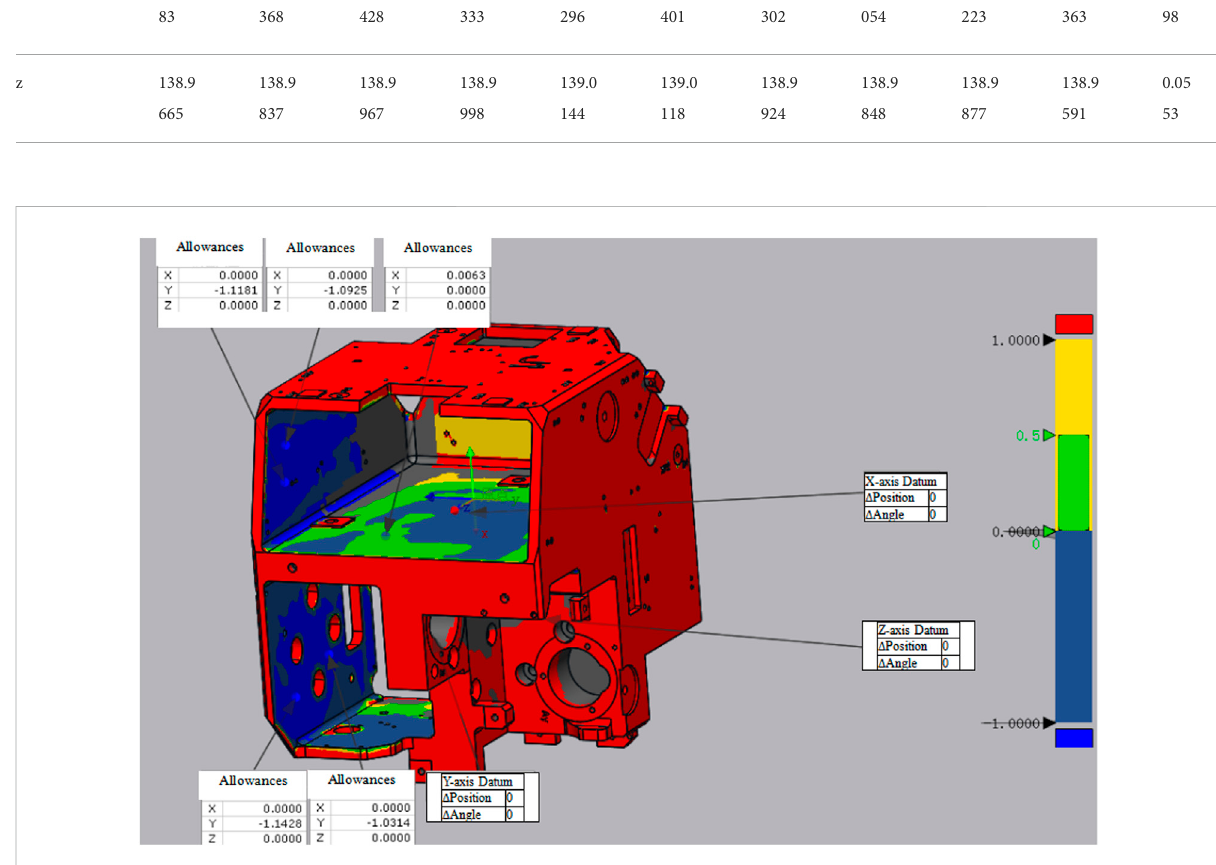
FIGURE 9 Distribution results of casting allowance. The material used in simulation settings is aluminum